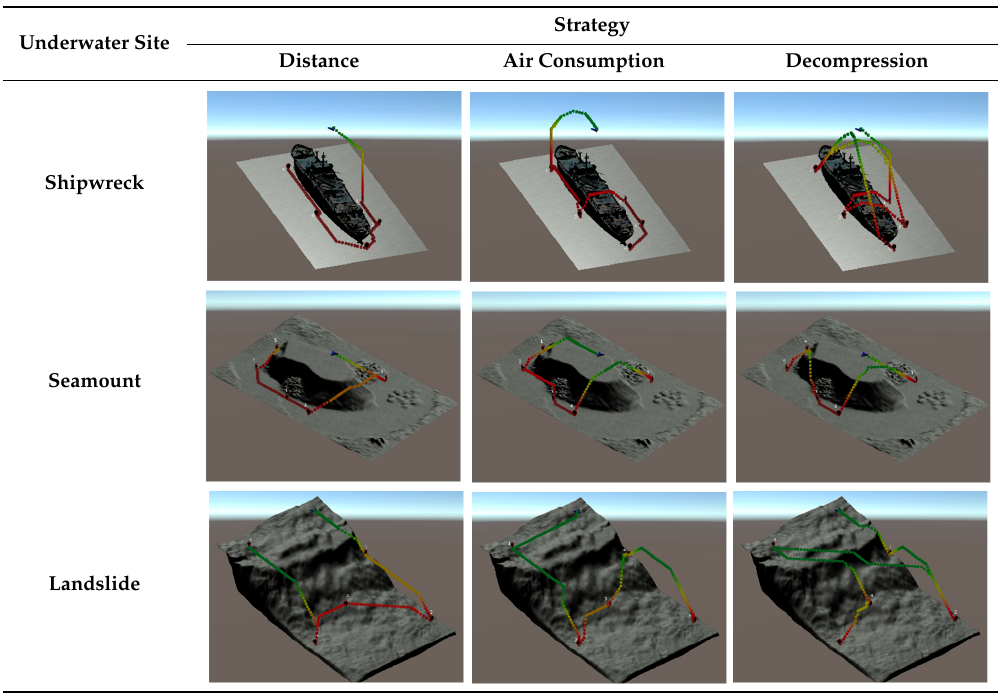
Table 2. The paths generated with three different strategies for three different case studies.